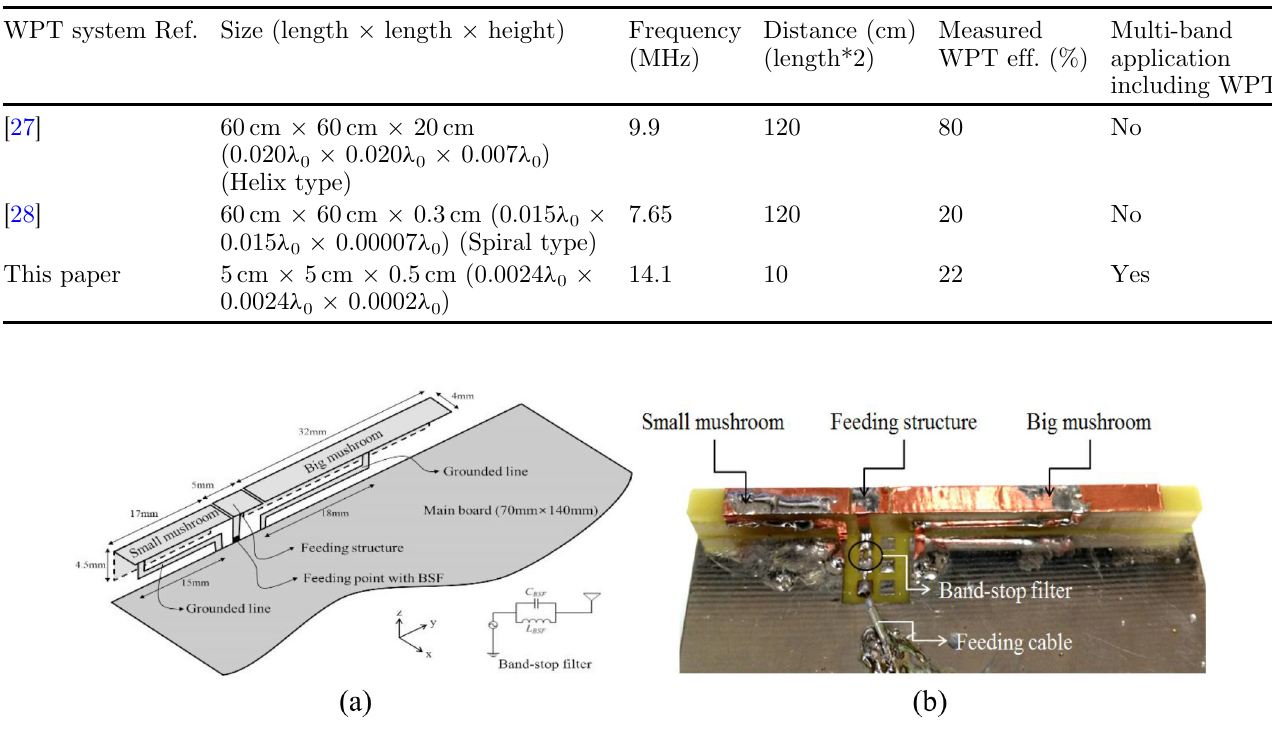
Fig. 12. (a) Structure and (b) photograph of the proposed dual ZOR